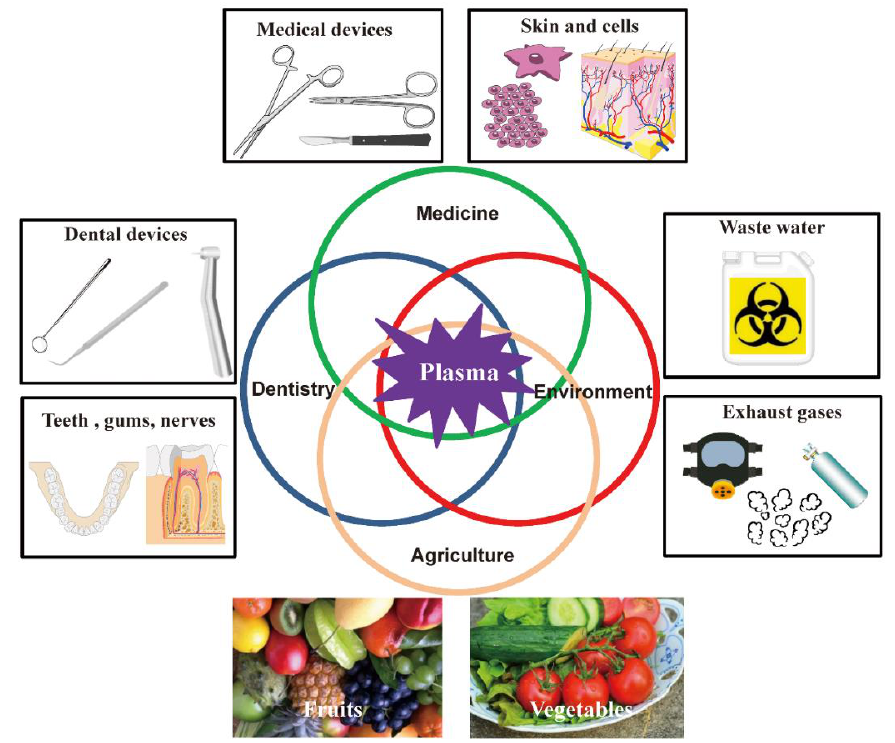
Figure 6. Recent and potential applications of plasma disinfection technology in the field of agriculture, medicine, dentistry, and environment. In the agricultural field, plasma technology could be applied to the disinfection of foods and packaging materials as well as agricultural sources such as seeds, fertilizers, waters and soils. In the medical field, plasma is useful for disinfection / sterilization of medical devices, as well as the degradation of toxins and other pathological contaminants. Potential applications of this technology also includes skin antisepsis as well as the treatment of pathogen-based skin diseases. In dentistry, plasma treatment has been used for microbicidal decontamination, including root canal disinfection and tooth disinfection. Plasma technology may also be utilized in the environmental field, including cleaning of wastewater as well as the treatment of exhaust gases.